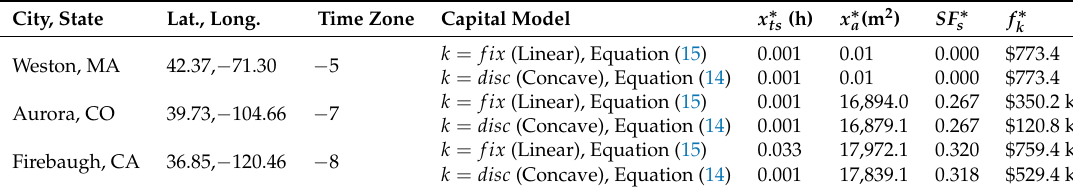
Table 4. The optimal solar-IPH hybridization strategies for the three geographic locations for periodic IPH demand with ¯ q p = 10 5 kW for the industrial fuel rate. The global optimal results for the concave capital cost model in Equation (14) are included for comparison against the linear capital cost model in Equation